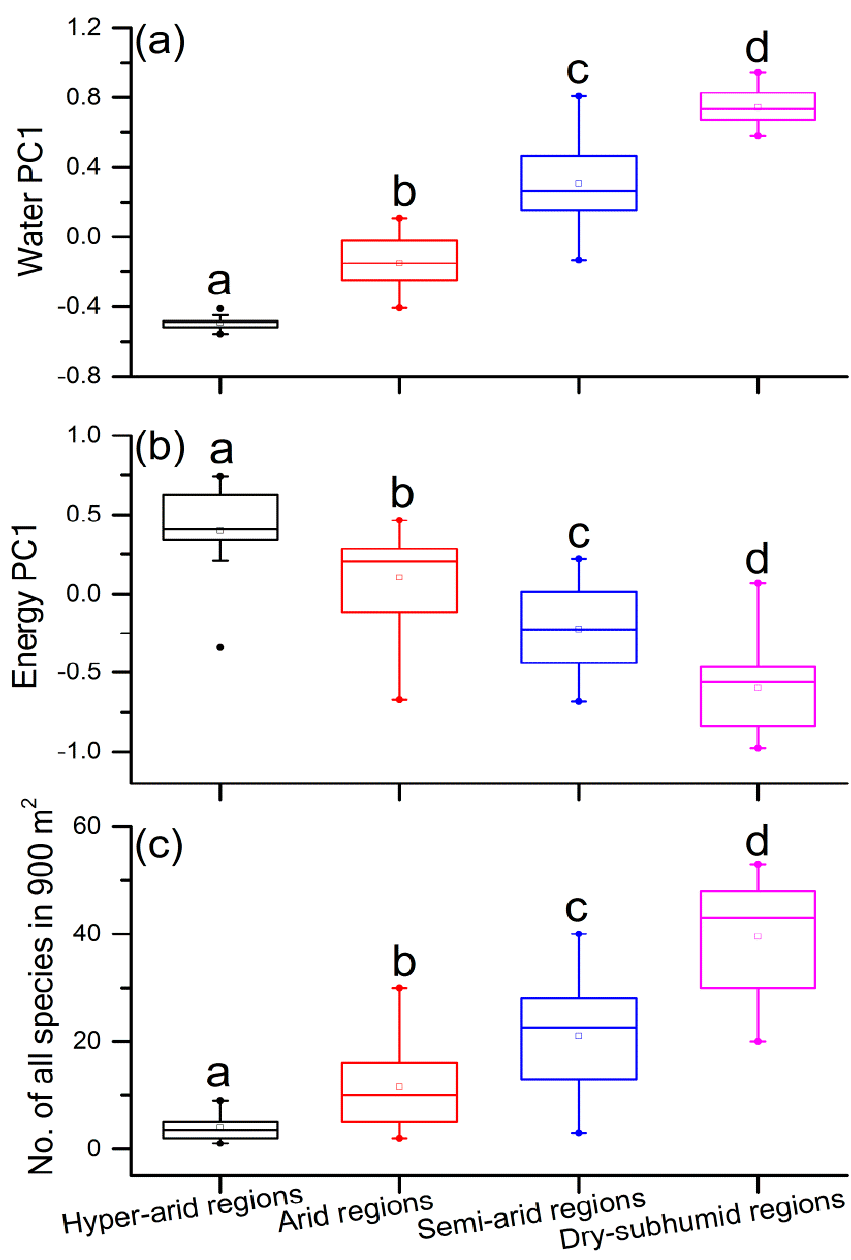
Figure 2. Boxplots for ( a ) water, ( b ) energy, and ( c ) plant diversity (number of all species in 900 m 2 in each site) based on the different aridity regions (hyperarid regions: n =26 sites; arid regions: n =91 sites; semiarid regions: n =50 sites; dry-subhumid regions: n =17 sites). Regions with the different letters are significantly different from each other at p < 0.05 by one-way ANOVA.